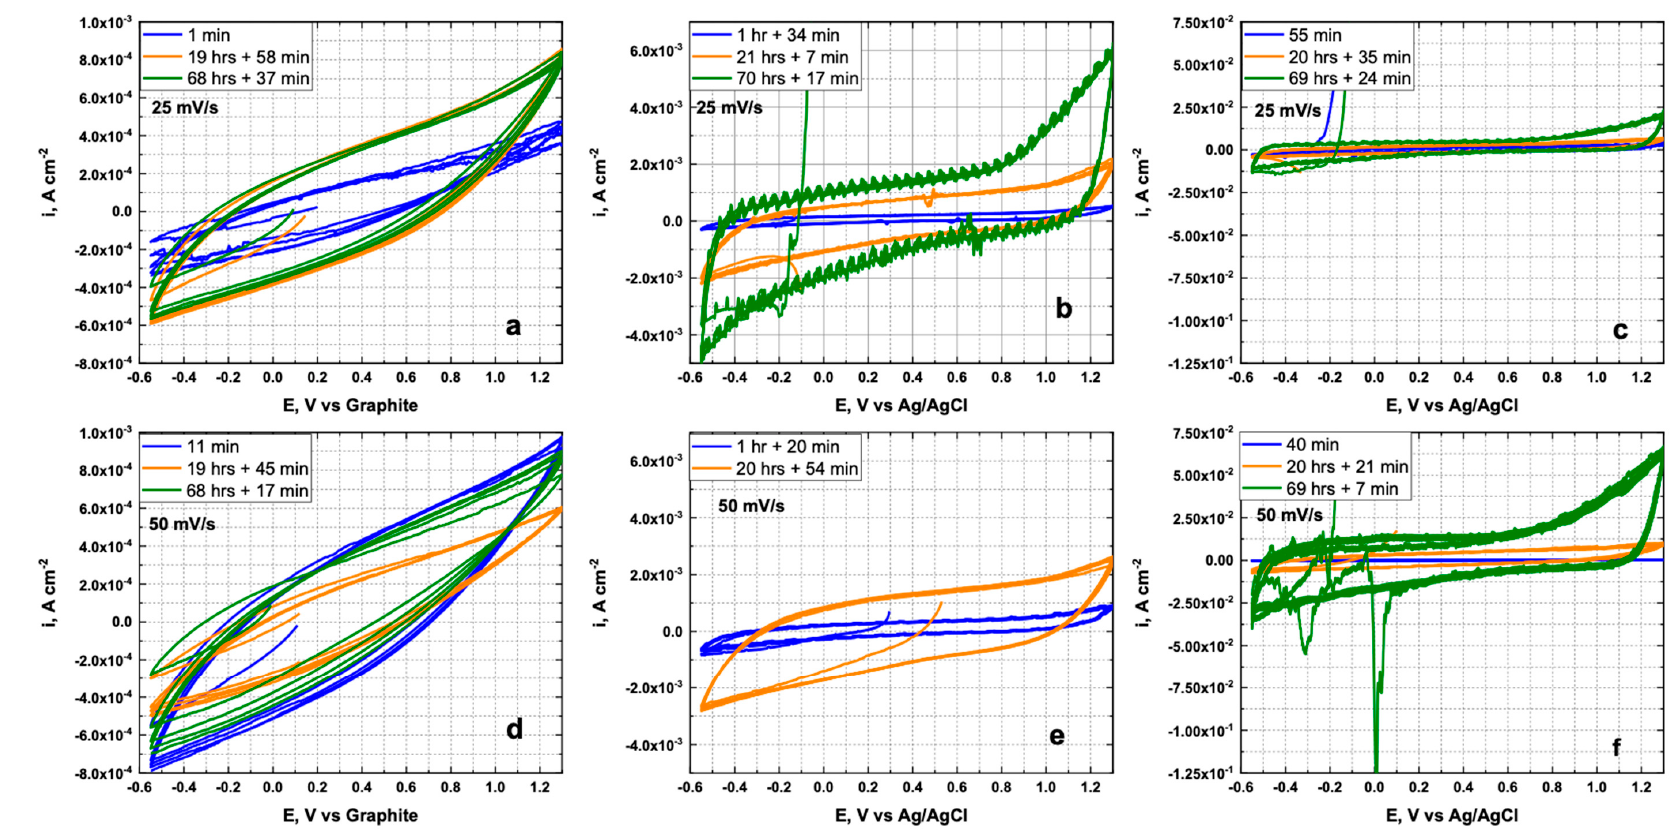
Figure 6. S 3: Electrochemical behavior of the MFC under vacuum conditions, at different reaction times and sweep potentials under cathode direction. The anode chamber was filled up with distilled water and the cathode chamber with a hydrochloric acid solution (0.1 M HCl, pH ≈ 1.8). ( a ) and ( d ), ( b ) and ( e ), and ( c ) and ( f ) correspond to the potentiostat settings A, B and C, respectively.